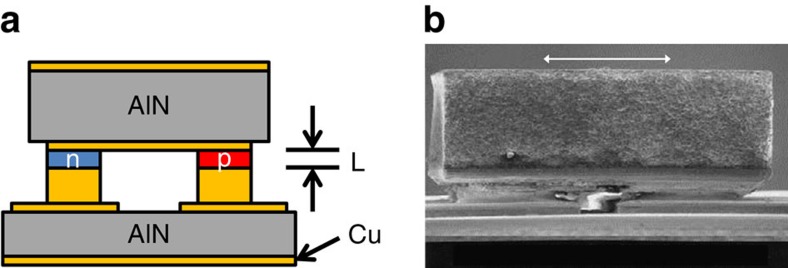
Cross-sectional views of a Bi2Te3-based thin-film thermoelectric module.(a) Illustration of thin-film-based thermoelectric module, showing top and bottom AlN headers, Cu traces and n-type and p-type active elements. L represents the length of the active elements, which is 8 μm in the present work. Figure is not to scale. (b) Scanning electron microscope image of the upper portion of a completed thin-film superlattice thermoelectric module. Scale bar, 250 μm.